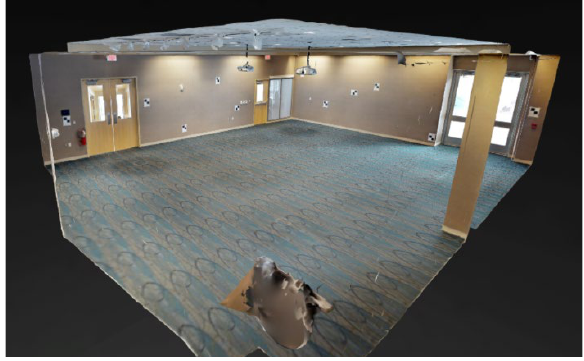
Figure 4. Matterport 3D model of the test field with control